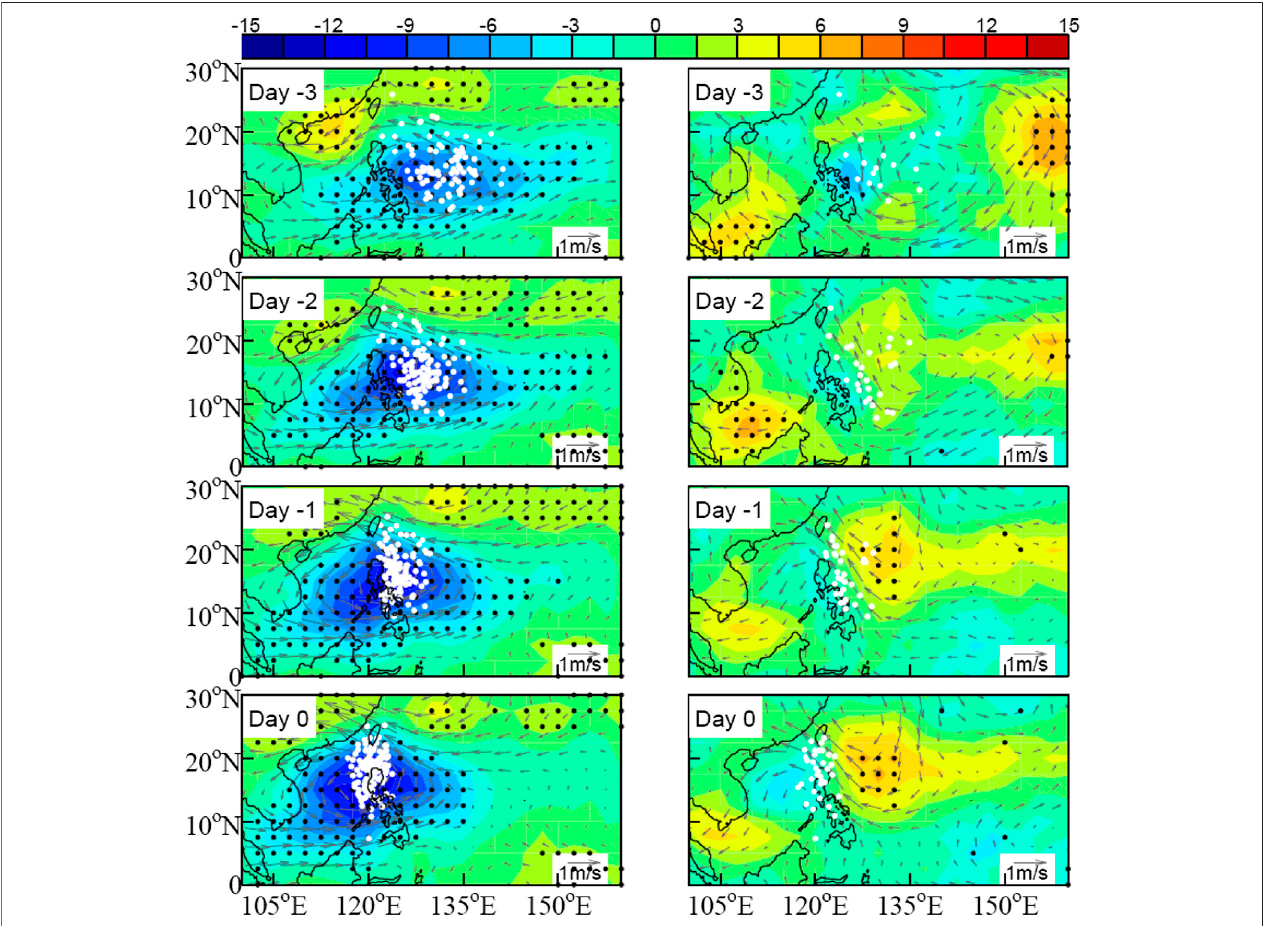
FIGURE 9 | The composite 10 – 20 days fi ltered OLR anomalies (color, W m − 2 ) and 850 hPa wind vectors (m s − 1 ) for nonlocal TCs entering the SCS in the active (leftpanels) andinactive (rightpanels) phasesofMJO.ThenumbermeansthedaysbeforethedatethatthenonlocalTCsenteredtheSCS.Thestipplingindicatesthe statistical signi fi cance of OLR at the 95%